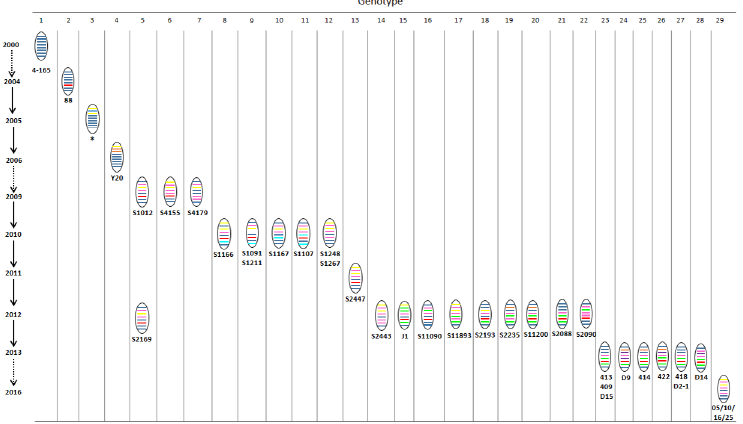
Fig 4. The genotypic evolution of H4N6 AIVs in China from 2000 to 2016. The eight gene segmentslisted are (top to bottom): PB2, PB1, PA, HA, NP, NA, M, and NS genes. The colors of the eight gene segmentsof the first isolate (A/duck/Nanchang/4-165/2000)were definedto be the same, and a new color represent a different lineagefrom this strain. The abbreviation of virus which possessed the corresponding genotypeare listed below the genotype. The gene constellation for different genotypes, the viruses that possessed these, and the abbreviationof virus name are given in S1 Table.